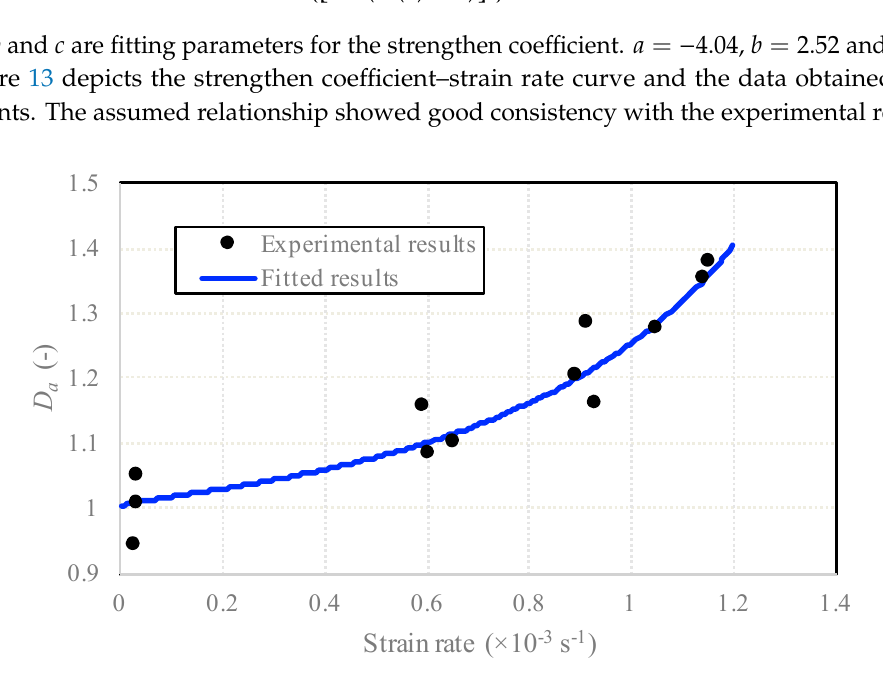
Figure 14. The dynamic inertia contribution with respect to the acceleration. 5. Numerical Simulation on the Mesoscopic Scale According to the mechanical characteristics of the three-point bending beam, the zone of 100 mm in the middle of the beam is considered as the pure bending section where endures the largest bending moment and the failure usually occurs. Hence, in the numerical simulation, the central part